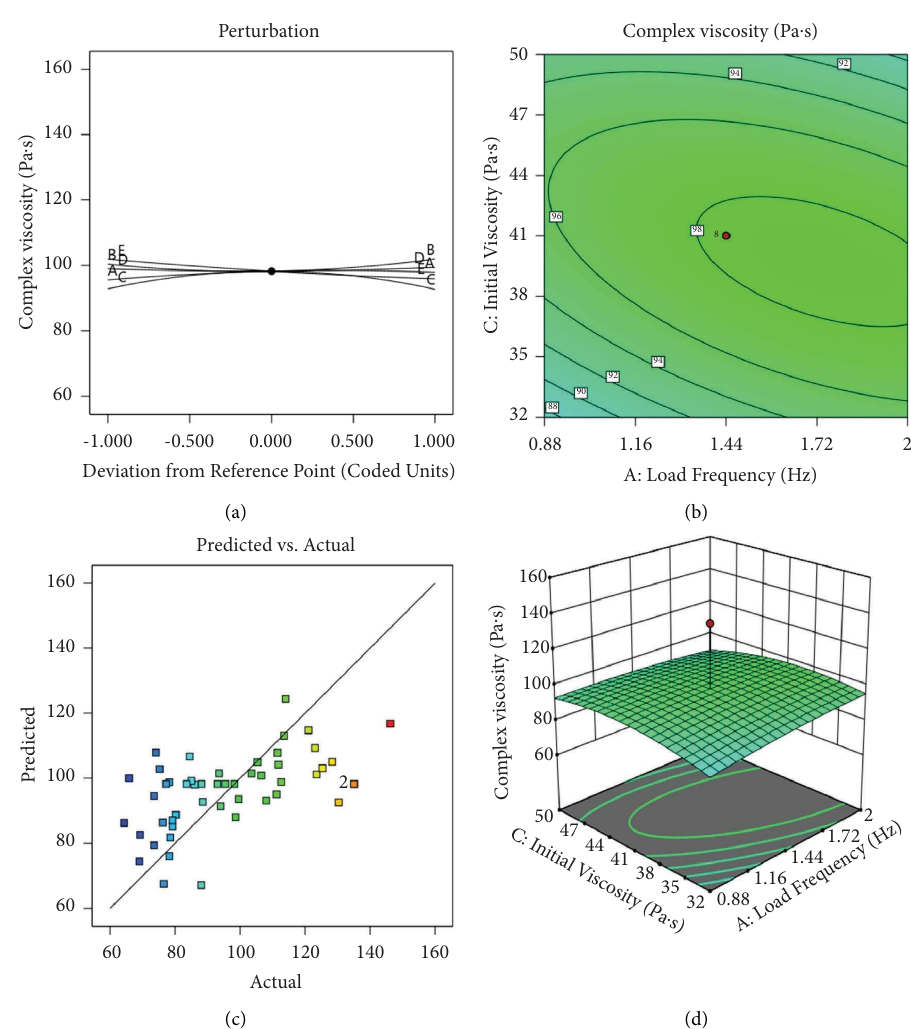
Figure 5: (a) Perturbation for complex viscosity. (b) Contour graph for complex viscosity. (c) Predicted vs. actual values for complex viscosity. (d) 3D graph for complex